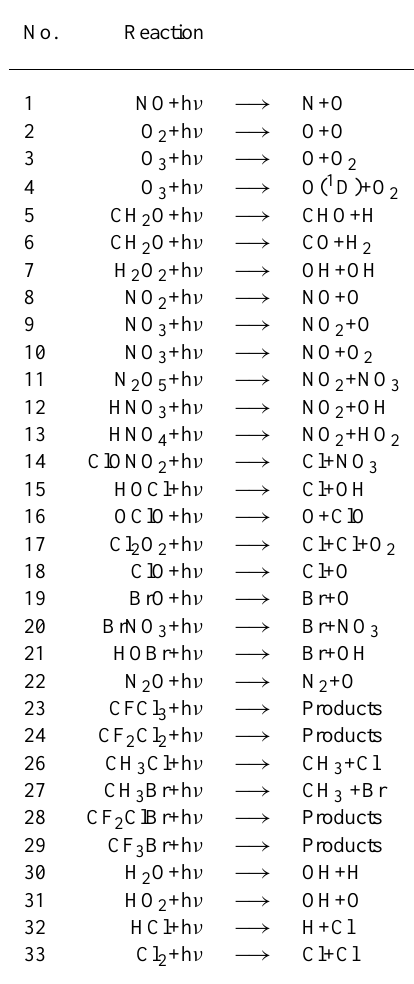
Table 3. Photolytic reactions in the model No.